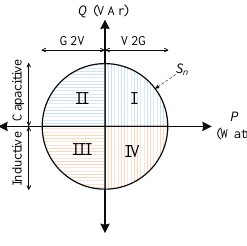
Figure 6. PQ capability characteristics of an EV smart